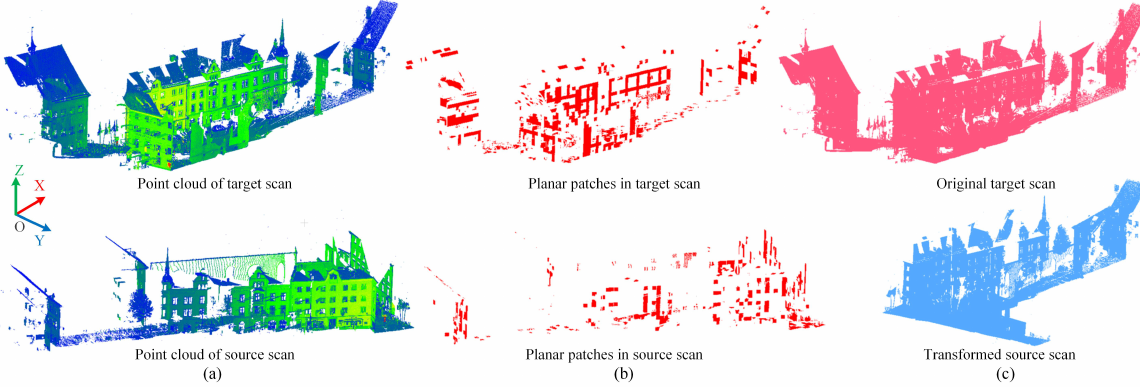
Figure 8. Registration results of ETH datasets. (a) Original scans. (b) Extracted planar patches. (c) Aligned scans